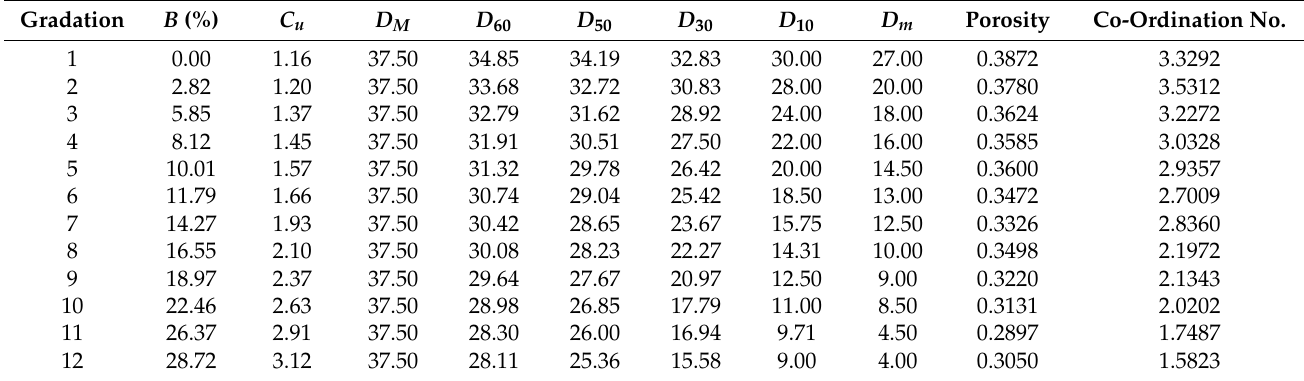
Table 3. Particle size distributions of the 12 gradations.